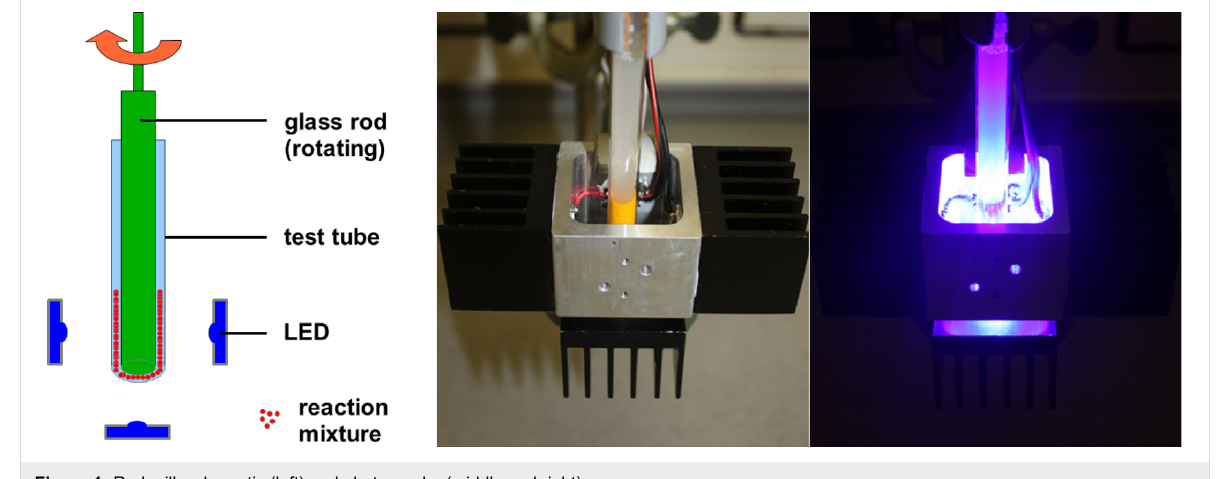
Figure 1: Rod mill, schematic (left) and photographs (middle and right).